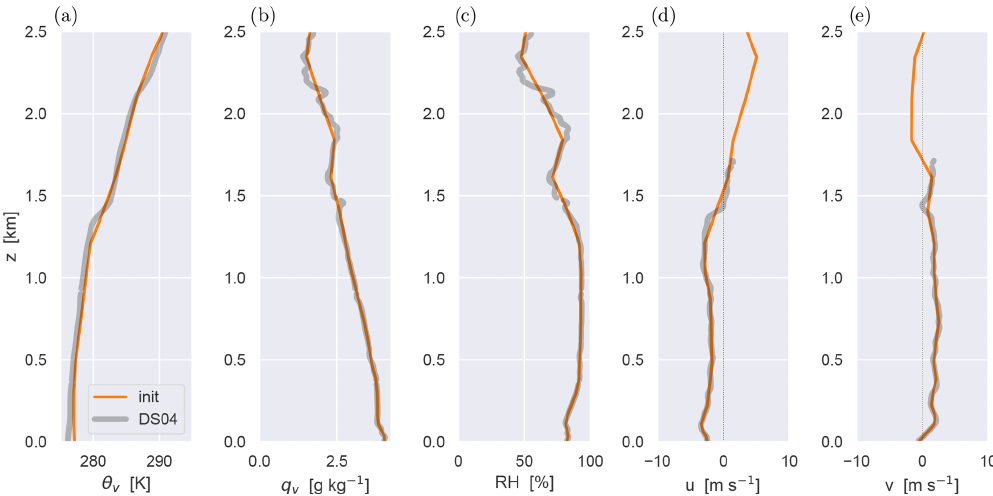
Figure 3. Dropsonde profiles from RF20 of (a) virtual potential temperature θ v ; (b) water vapor specific humidity q v ; (c) relative humid- ity RH; and the (d) zonal and (e) meridional wind speeds u and v , respectively. The DS04 sounding is shown in grey. The idealized initial (init) profiles are shown in orange.